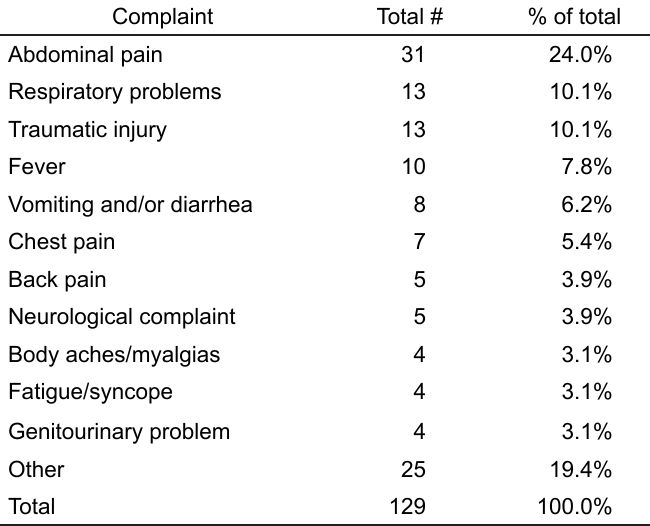
Table 4. Chief complaint by age,